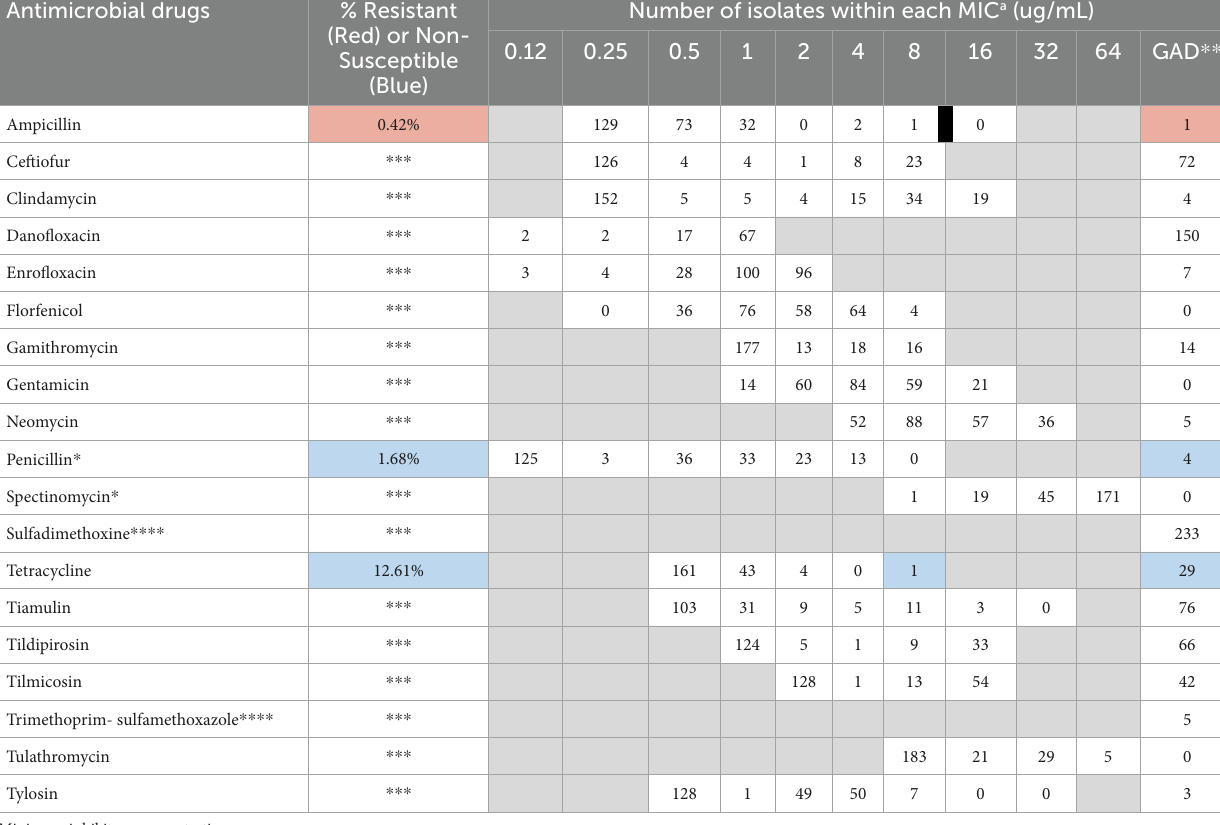
a Minimum inhibitory